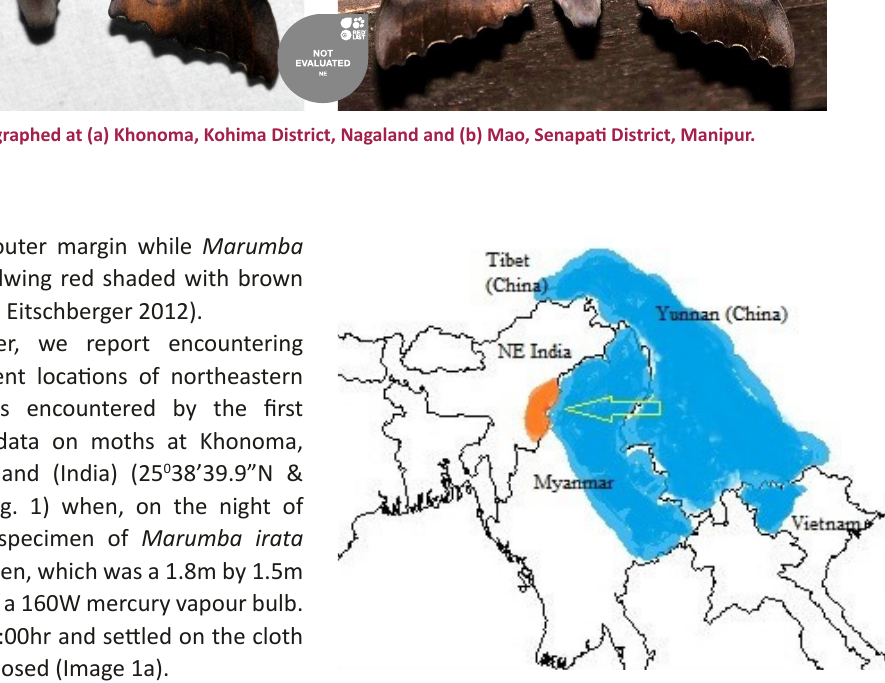
Figure 1. Map showing collecting localities Khonoma, Nagaland and Mao, Manipur of northeastern India (Red colour) and distribution area (Blue colour) of the Marumba